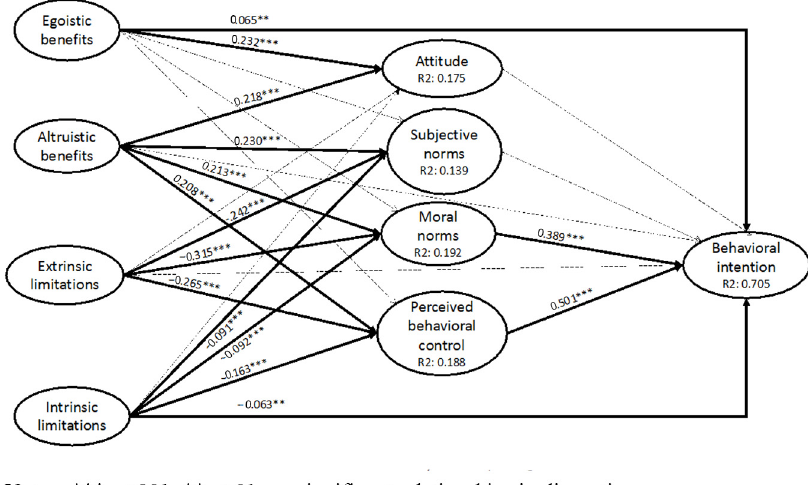
Figure 2. Results of the